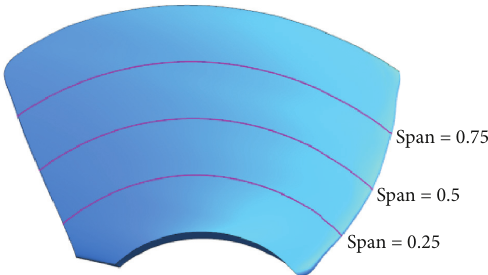
Figure 14: Location of blade